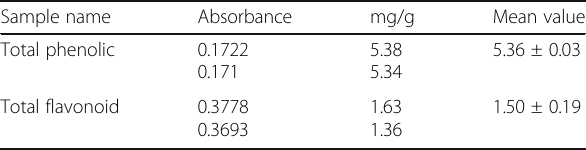
Table 2 Total phenolic and flavonoid content in algal biomass from HRAP